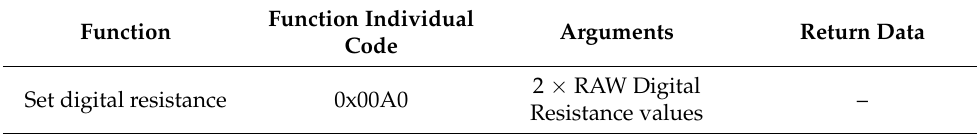
Table 6. CAN transaction for setting offset for SiPM signal